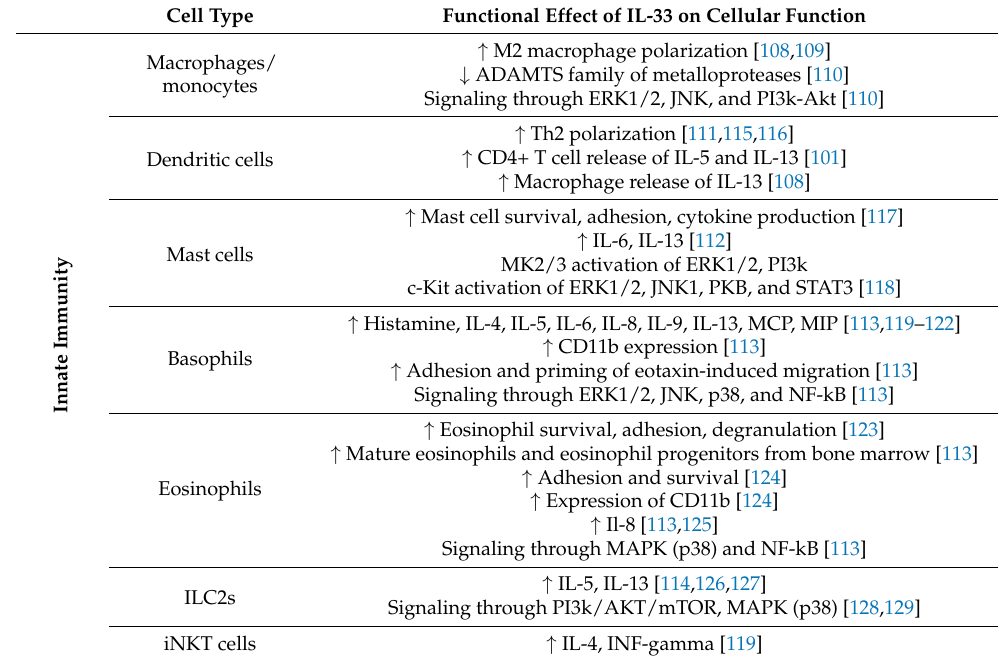
Table 2. IL-33 and pathogenic effects in asthmatic